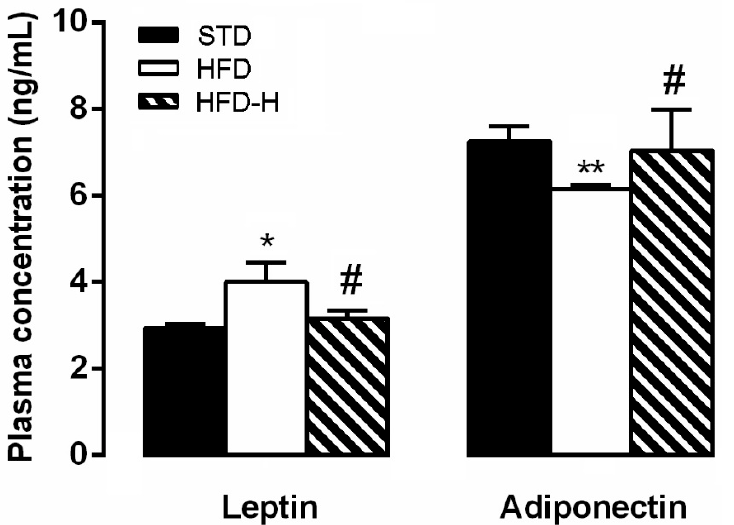
Figure 6. Effects of long-term honey ingestion on leptin and adiponectin concentration in HFD mice. Honey prevented the changes in plasma levels caused by HFD. Data are mean values ± S.E.M. ( n = 8/group). * p < 0.05, ** p < 0.01 vs. STD mice; # p < 0.05 vs. HFD. STD: standard mice; HFD: high fat diet mice; HFD-H: high fat diet supplemented with honey mice.